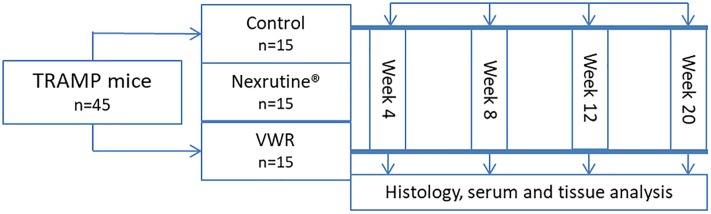
Experimental study design.